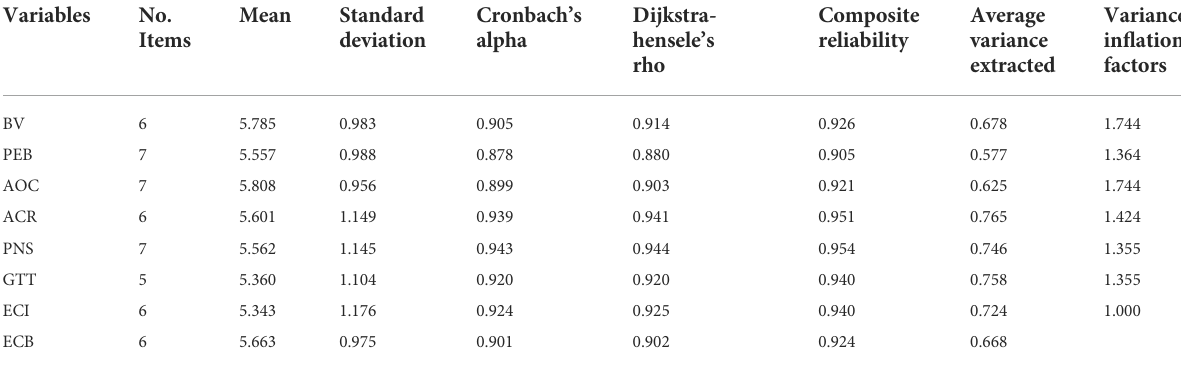
TABLE 3 Reliability and